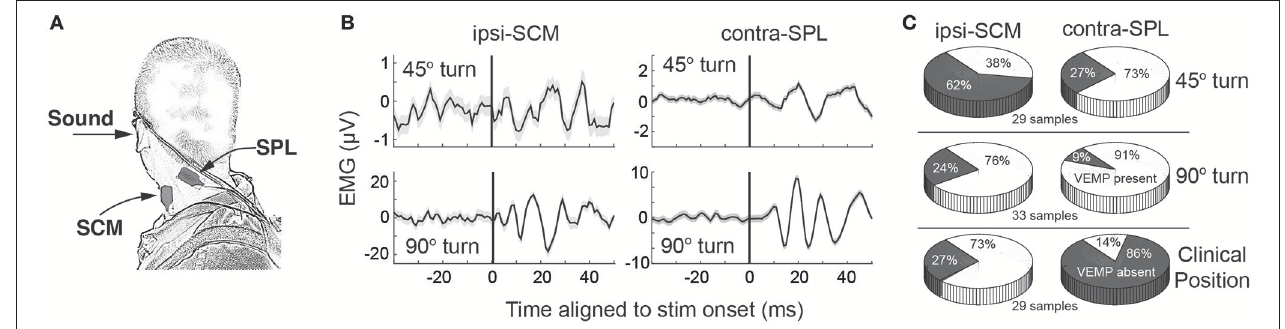
FIGURE 6 | (A) Electrode placement to assess cVEMPs from ipsilateral SCM and contralateral SPL. The contralateral SPL electrode is not shown, but is in the mirroring position of that shown here. (B) cVEMPs on ipsilateral SCM and contralateral SPL during a modest 45 or more extreme 90 head turn away from the stimulated ear. (C) Comparative likelihood of recording a cVEMP on ipsilateral SCM or contralateral SPL for various postures. Same format as Figure 1B . All parts of this figure take from data presented in Camp et al. (107), with permission from Wiley and